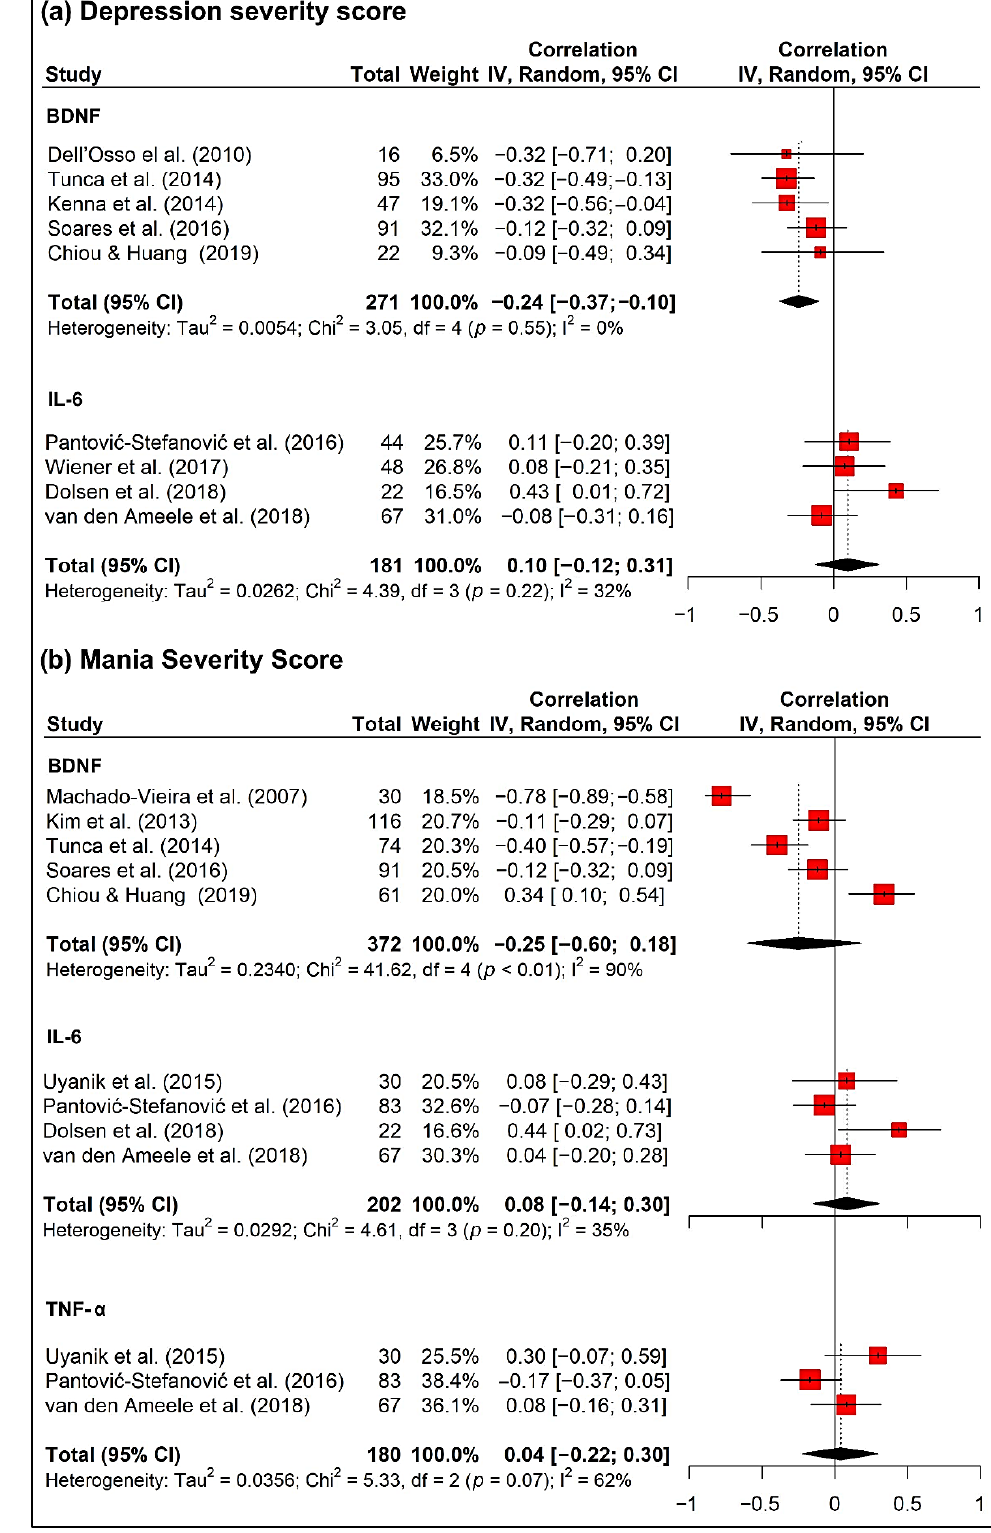
Figure 4. Forest plot of correlations between inflammatory factors (BDNF, IL-6 and TNF- α) and ( a ) depression severity score (HDRS or MADRS) from the data of selected studies (11, 12, 13, 21, 30b, 35, 40, 42, 44a in Table 1) and ( b ) mania severity score (YMRS) from the data of selected studies (11, 13, 22, 26, 35, 40, 42, 43, 44a in Table 1).